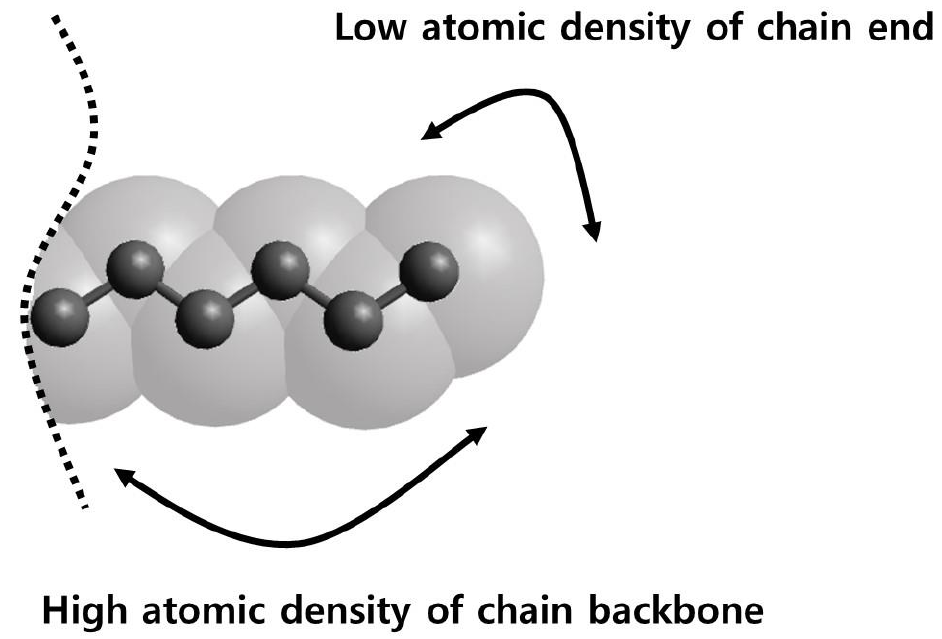
Figure 5. Schematic representation of the terminal portion of polyethylene (PE) chains by the ball-and-stick (connected black circles) and space-filling (silver-white) models; the black dotted line represents the remainder of a PE chain and the black arrows highlight the chain-end region vs. the backbone-like region.